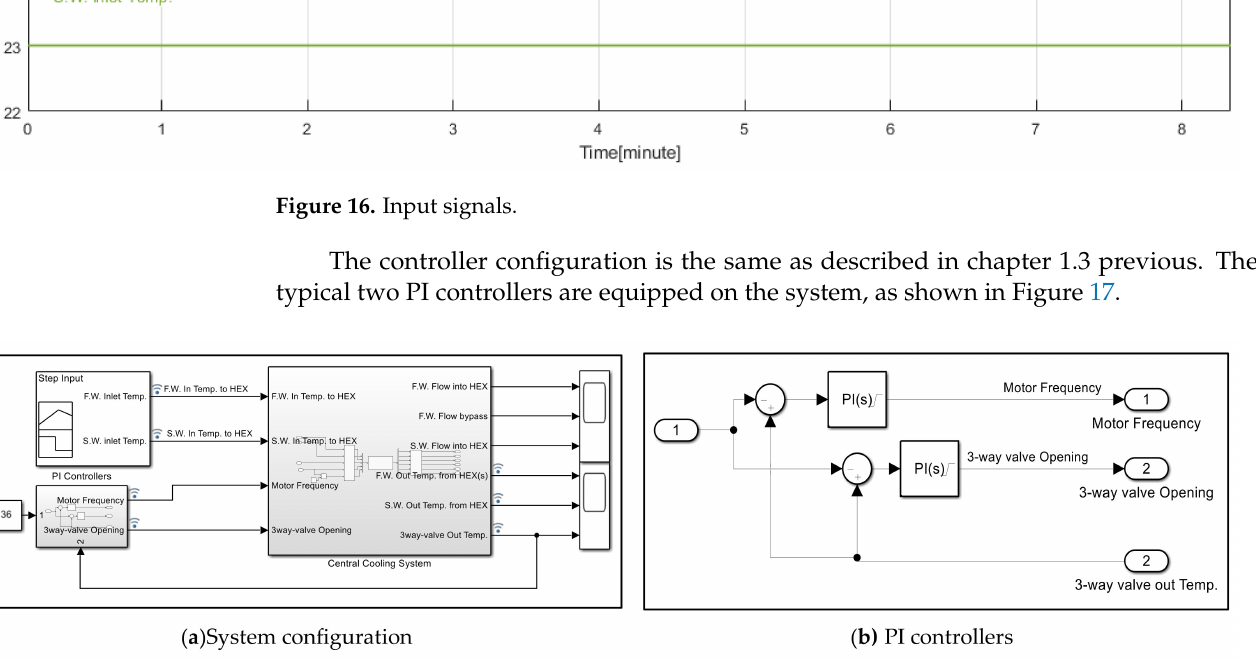
Figure 17. Control system configuration with two PI controllers. ( a ) System configuration; ( b ) PI